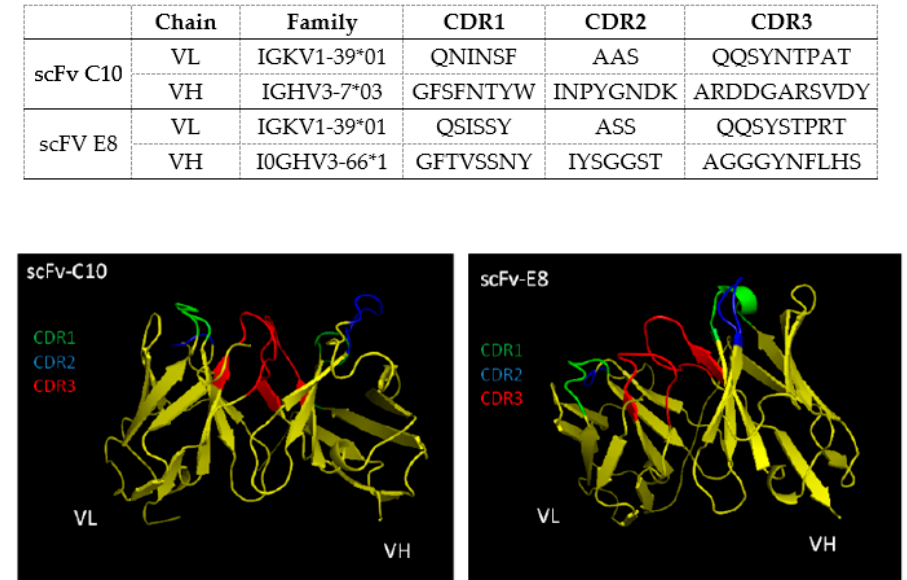
Figure 3. Characterization of the selected scFv clones. The amino acid sequences and three-dimensional structures of scFv-E8 and C10 clones, the CDR residues, variable light-chain (VL) and the variable heavy-chain (VH) domains are shown.